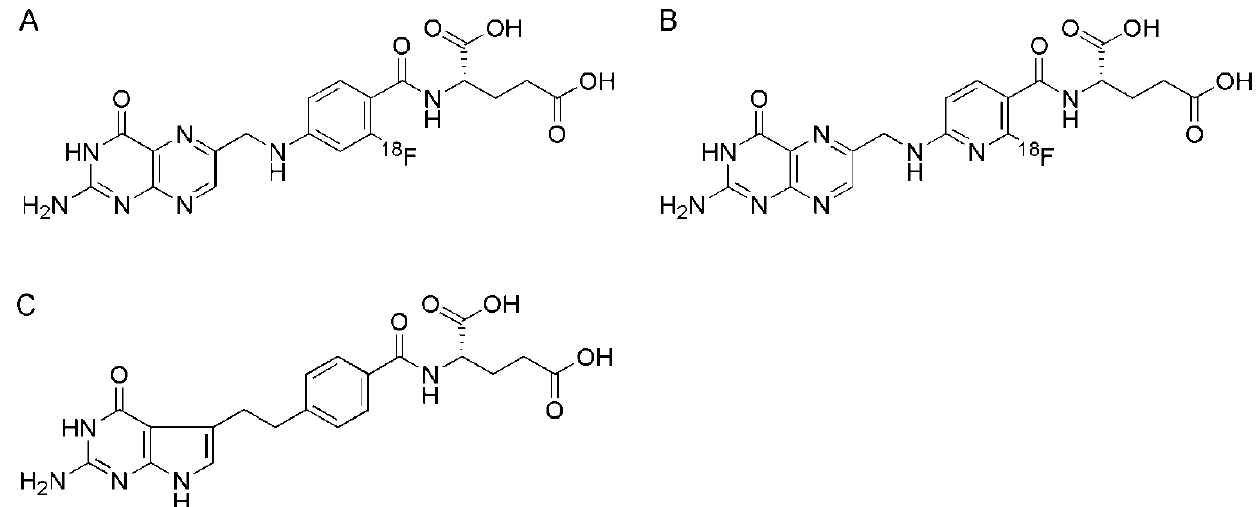
Figure 6. ( A ) Chemical structures of 2'-[ 18 F]fluorofolic acid, ( B ) 3'-aza-2'-[ 18 F]fluorofolic acid and ( C )